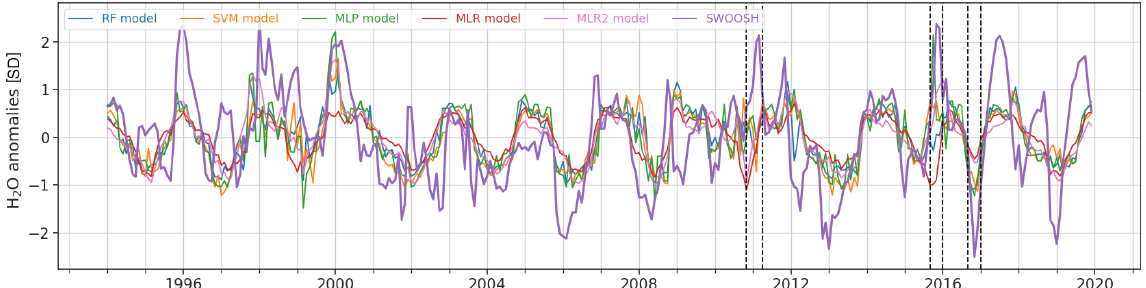
Figure 4. Out-of-sample model predictions of deseasonalized and standardized water vapor anomalies at 82.54hPa, averaged between 15 ◦ S and 15 ◦ N. The various models are RF (blue), SVM (orange), MLP (green), MLR (red) and MLR2 (pink). The MLR2 model is the same as the MLR model but with ENSO 2 and ENSO × QBO predictors. The observations are from SWOOSH (bold purple). Note the three forecast busts: 2010-D-2011-JFM, 2015-OND and 2016-OND.